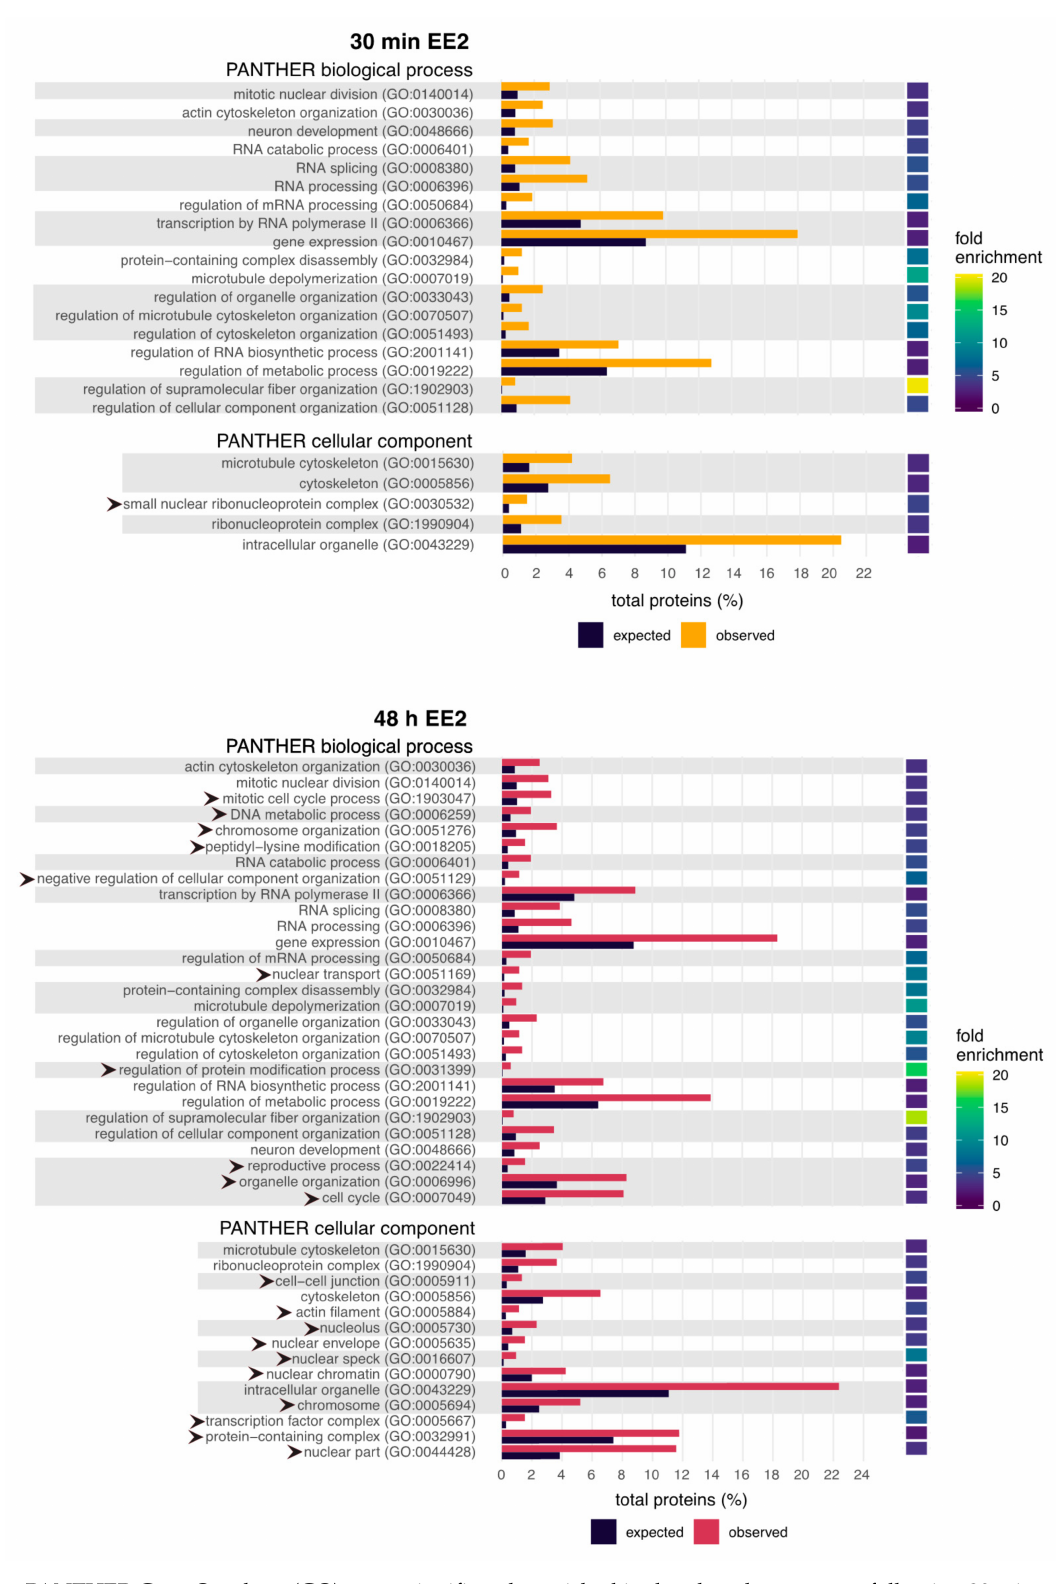
Figure 5. PANTHER Gene Ontology (GO) terms significantly enriched in the phosphoproteome following 30 min or 48 h of EE2 treatment. Terms clustered together by the grey/white background indicate those related by hierarchy. The horizontal bar plot denotes the percentage total number of expected and observed proteins for PANTHER biological processes and cellular components that were significantly enriched (Fishers exact test; corresponding fold enrichment show on the far right) following either 30 min ( top ) or 48 h ( bottom ) of EE2